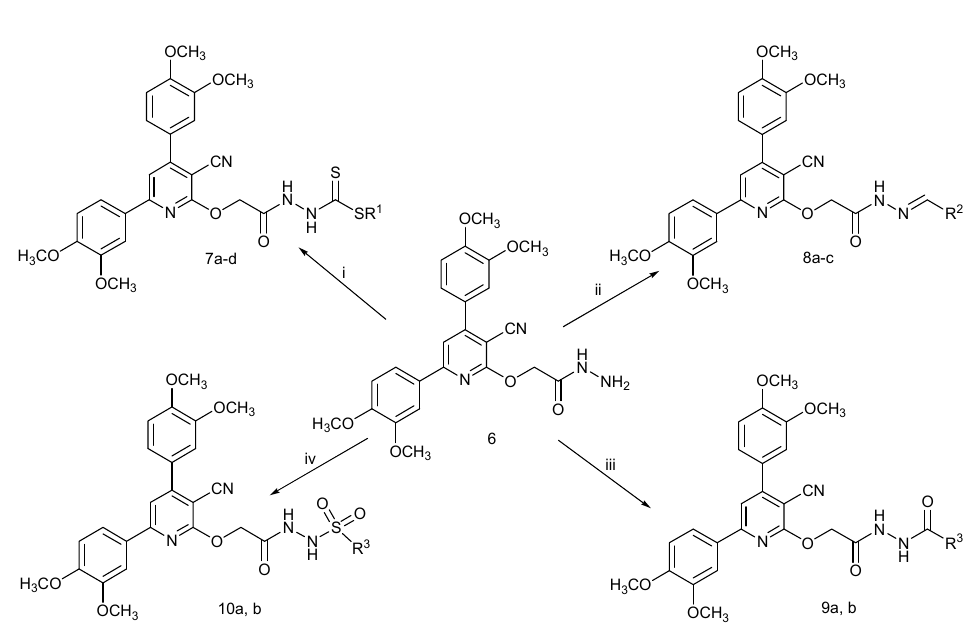
Scheme 2. Synthesis of the target compounds 7 – 10 . For 7 : a, R 1 = CH 3 ; b, R 1 = C 2 H 5 ; c, R 1 = 4-ethylmorpholine; d, R 1 = 4-ethylpiperidine; 8 : a, R 2 = 4-OCH 3 C 6 H 4 ; b, R 2 = 3,4-OCH 3 C 6 H 3 ; c, R 2 = 3,4,5-OCH 3 C 6 H 2 ; 9 , 10 : a, R 3 = C 6 H 5 ; b, R 3 = 4-OCH 3 C 6 H 4 ; Reagents and conditions : (i) CS 2 /KOH/DMF/ the appropriate alkyl halide/RT; (ii) the appropriate aldehyde/EtOH/CH 3 COOH/reflux; (iii) benzoyl or p -methoxy-benzoyl chloride/dry pyridine/RT; (iv) benzenesulfonyl or p -methoxybenzenesulfonyl chloride/dry pyridine/RT.